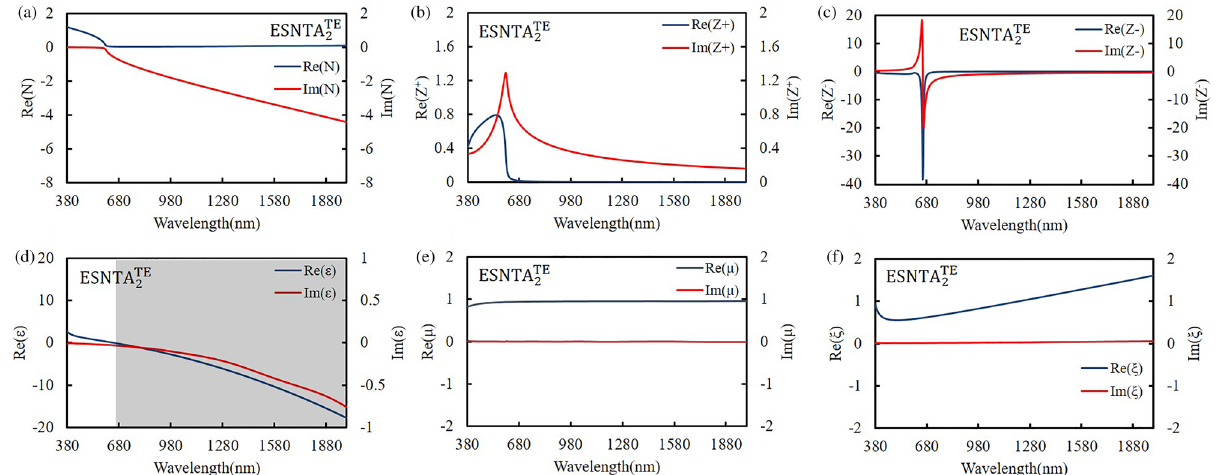
Figure 12. Retrieved ( a ) refractive index, ( b ) positive impedance, ( c ) negative impedance, ( d ) permittivity, ( e ) permeability, and ( f ) bianisotropy parameter for ESNTA 2 TE .